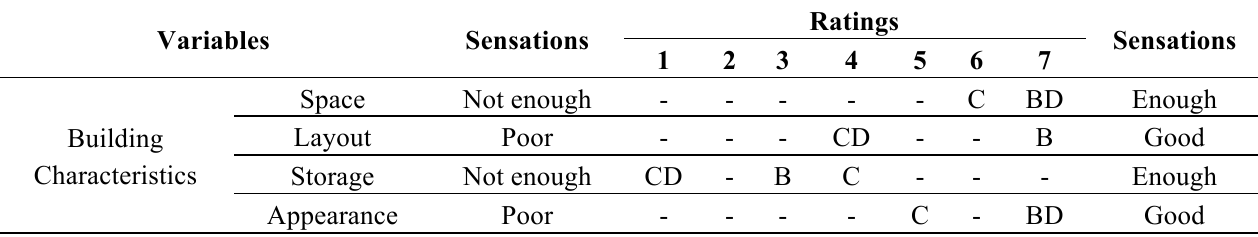
Table 5. Building Use Studies (BUS) surveys: User perceptions regarding spatial and characteristic qualities of housing units and the building.